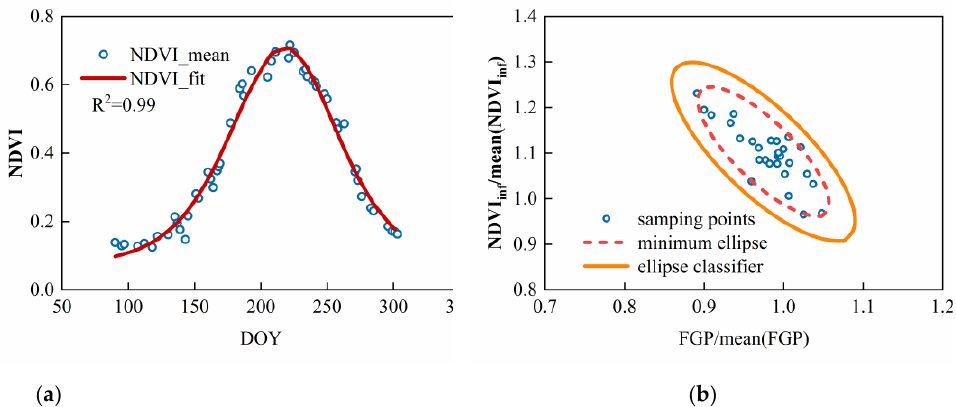
Figure 4. Mean NDVI series for sampled points and fitted asymmetric logistic function in 2012 ( a ) and the developed ellipse classifier ( b ).